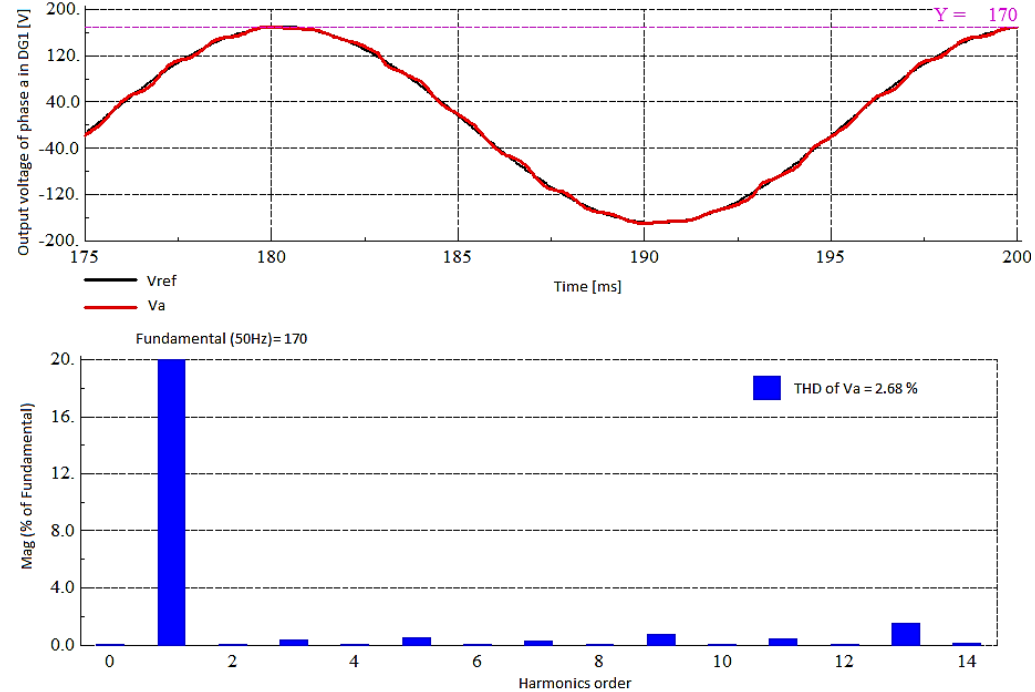
Figure 21. The output voltage of phase ‘a’ with the proposed harmonic compensation loop .